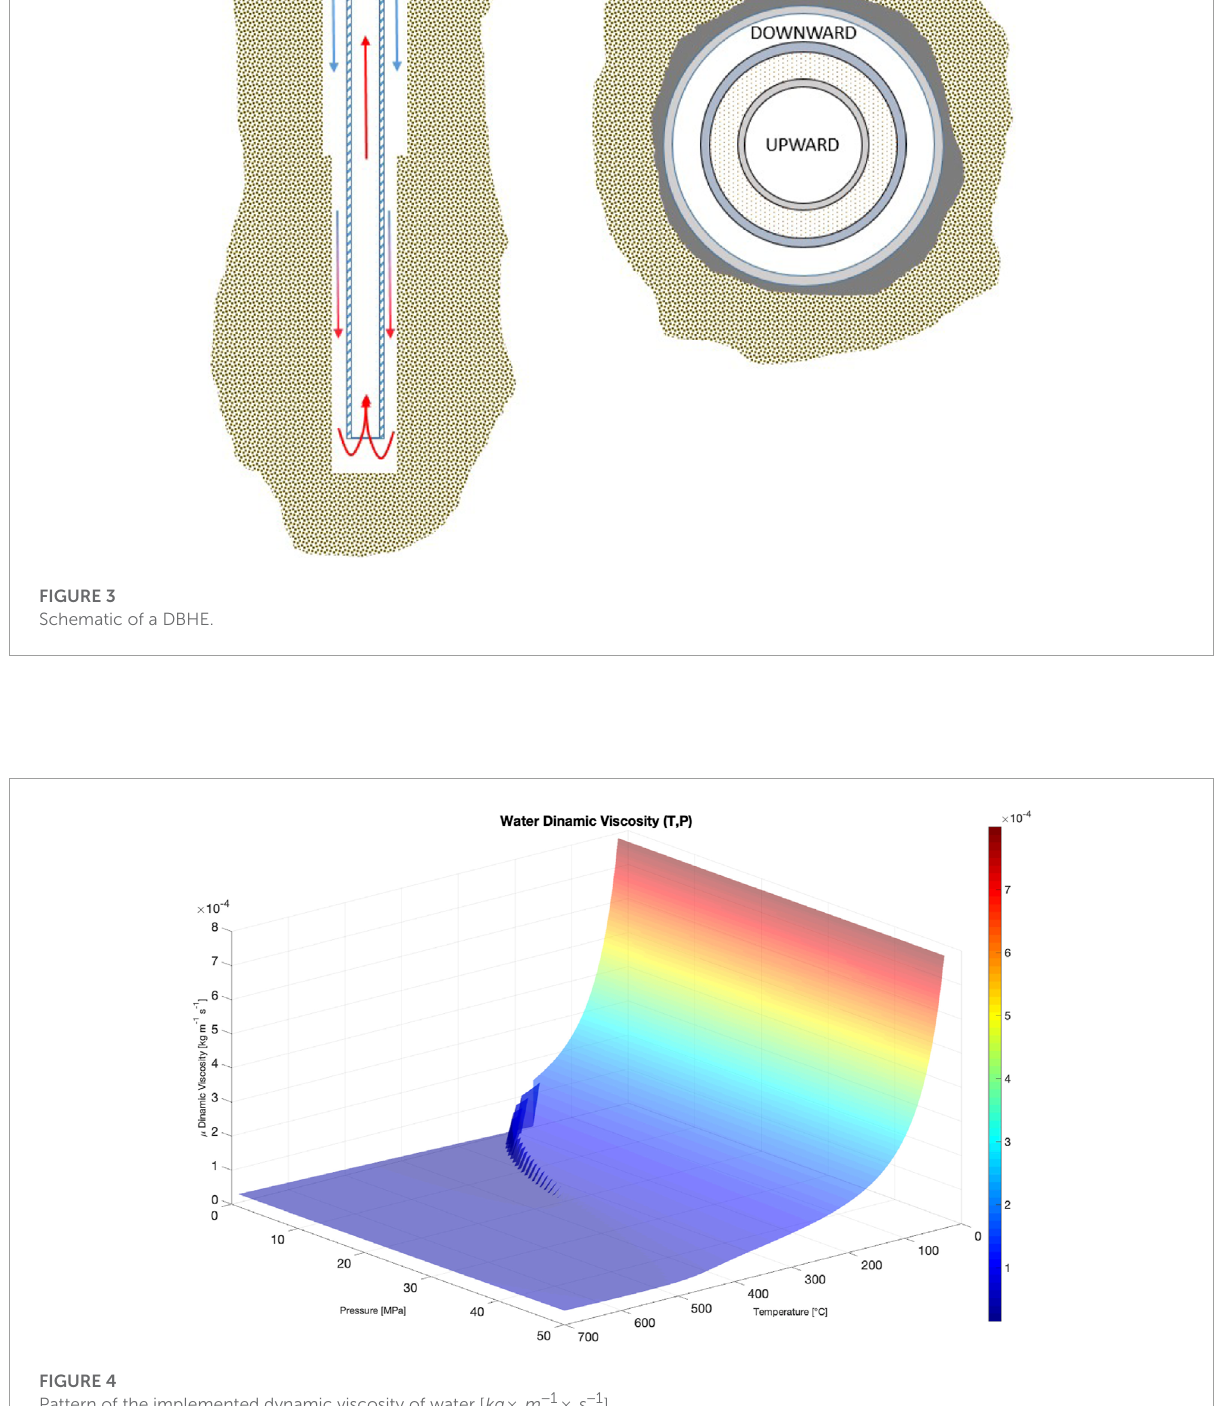
FIGURE 4 Pattern of the implemented dynamic viscosity of water [ kg × m −1 × s −1 ]